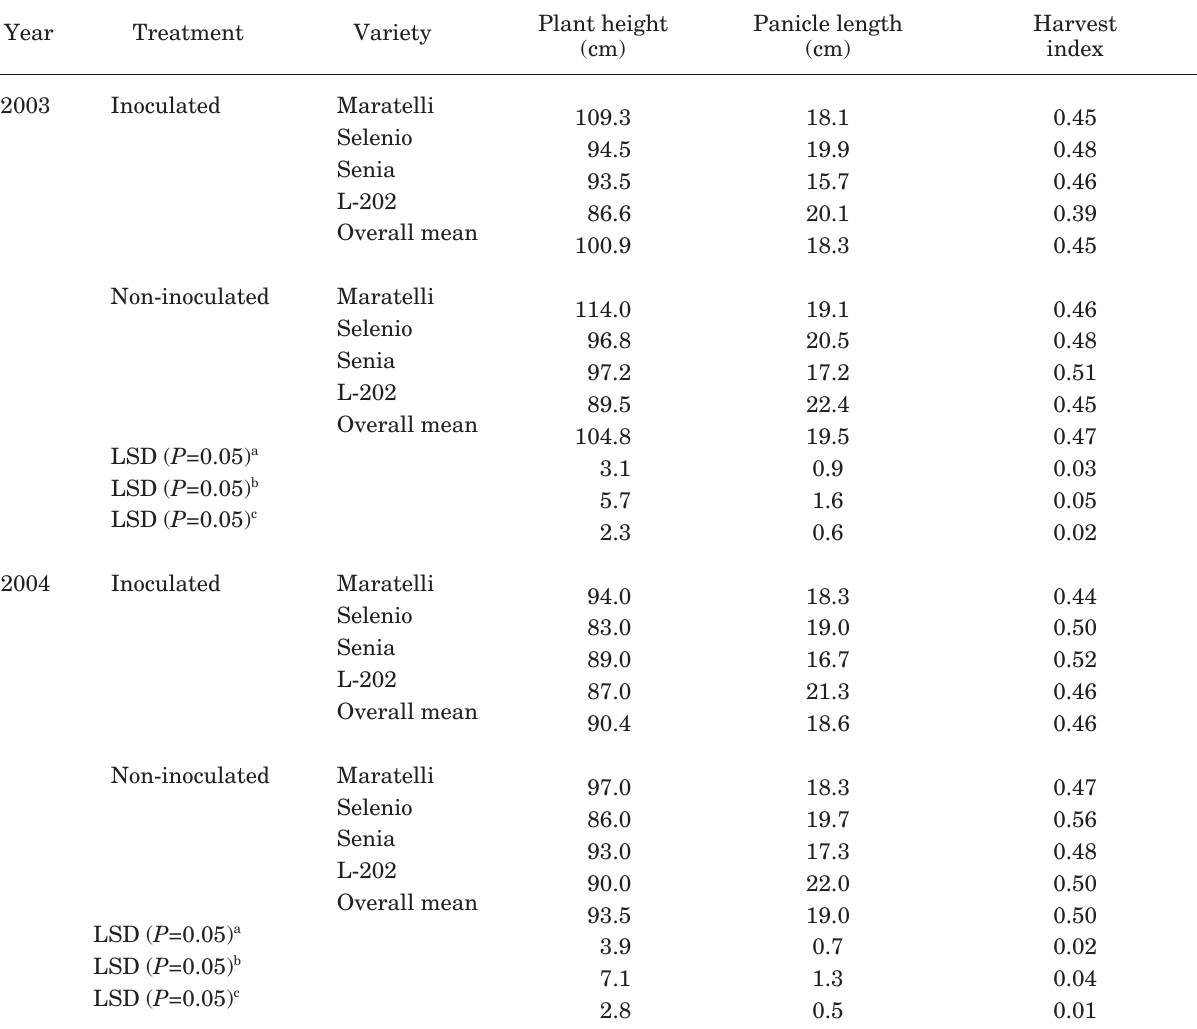
Table 1. Plant height, panicle length and harvest index of four rice varieties inoculated and non-inoculated with Magnaporthe grisea in field experiments conducted in 2003 and